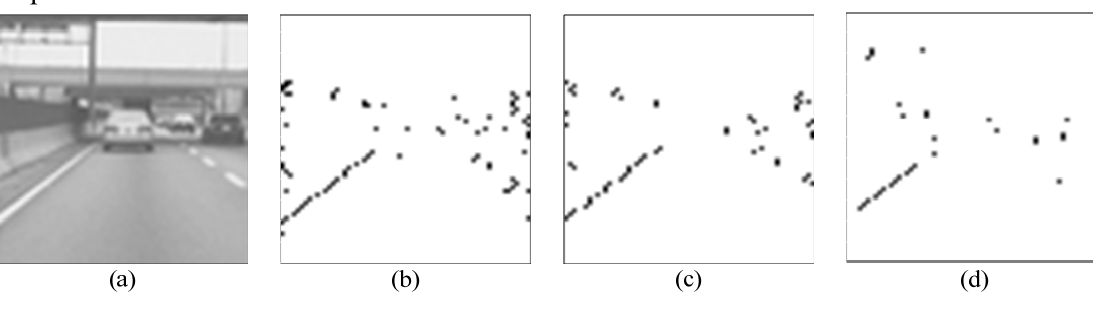
Figure 13. Comparison of experimental results (a) Raw image; (b) is the result of the peak- finding module; (c) is the result of the proposed CMOS imager; (d) is the result of software